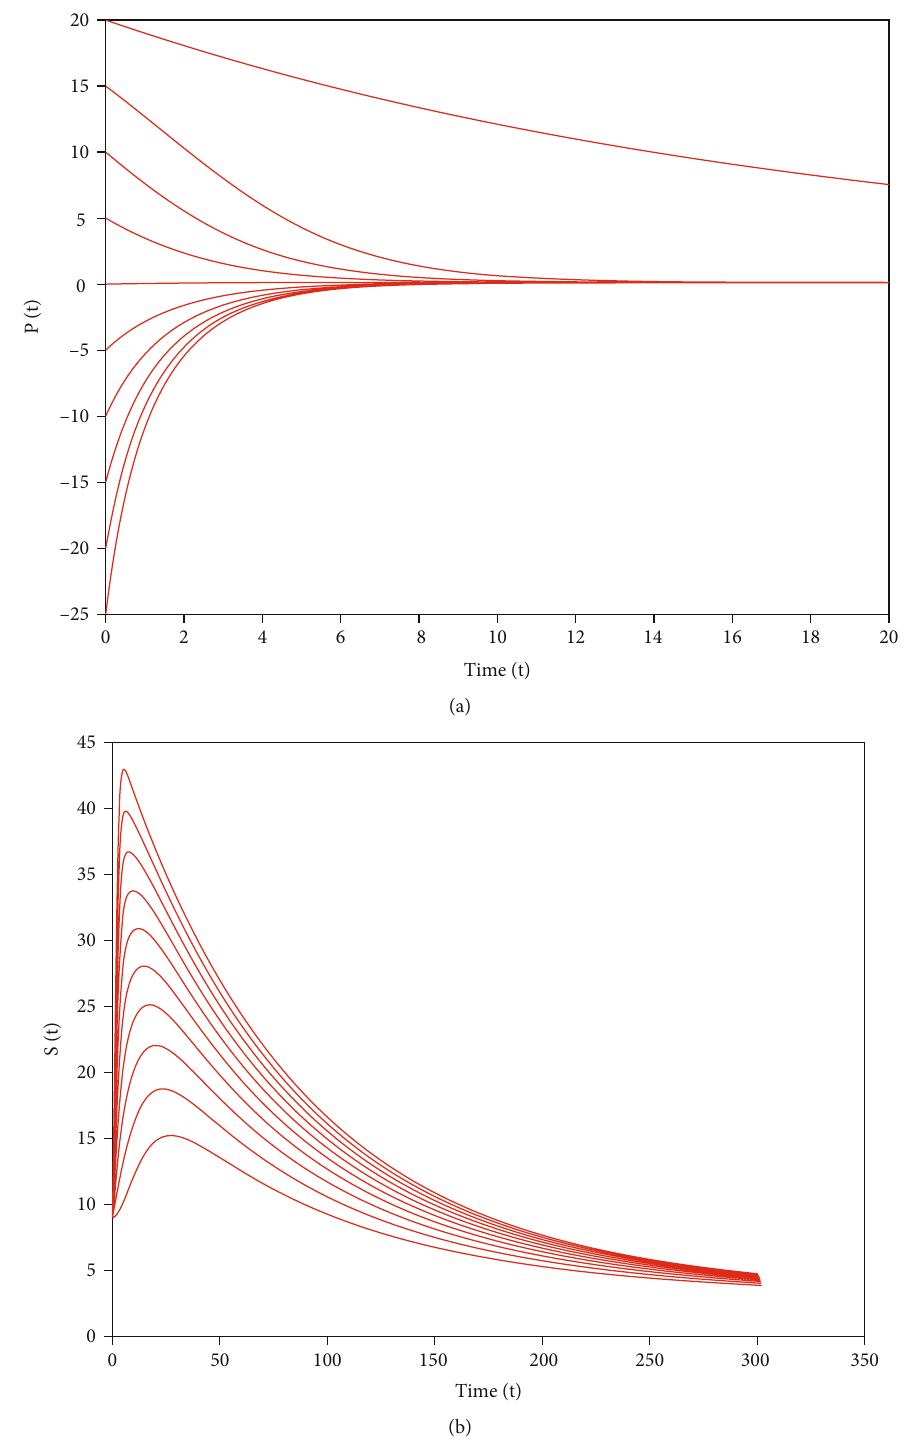
Figure 5: The stability curves of P ð t Þ and S ð t Þ at E ∗ for ω = 0 : 97 and ν = 0 : 5